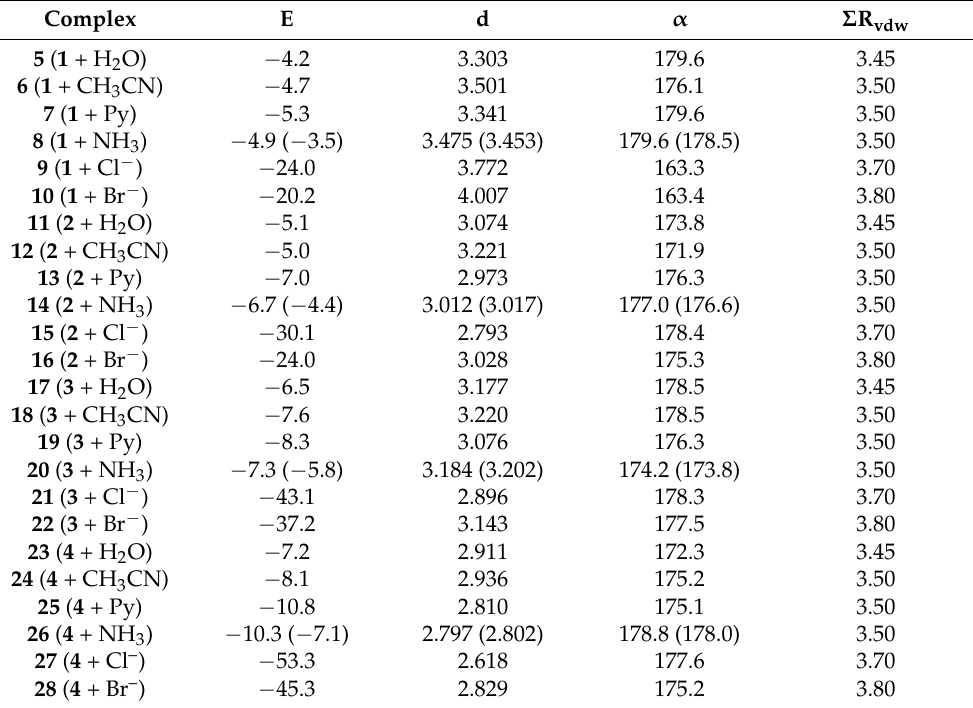
Table 1. Interaction energies (E, kcal/mol), equilibrium distances (d, Å) and Y: ··· Se=O angles ( α , ◦ ) for complexes 5 – 28 at the PBE0-D3/def2-TZVP level of theory. Values in parenthesis correspond to MP2/def2-TZVP level of